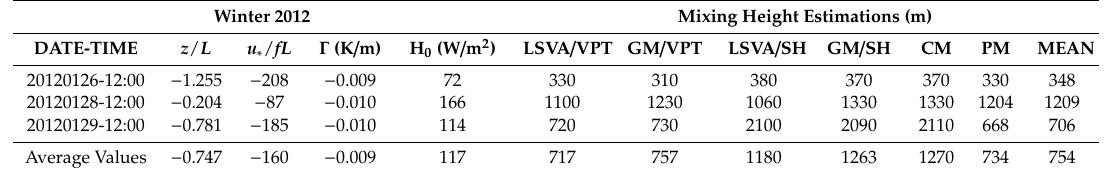
Table 5. Estimation of the Mexicali Valley convective mixing height from atmospheric soundings. Winter 2012 Mixing Height Estimations (m)